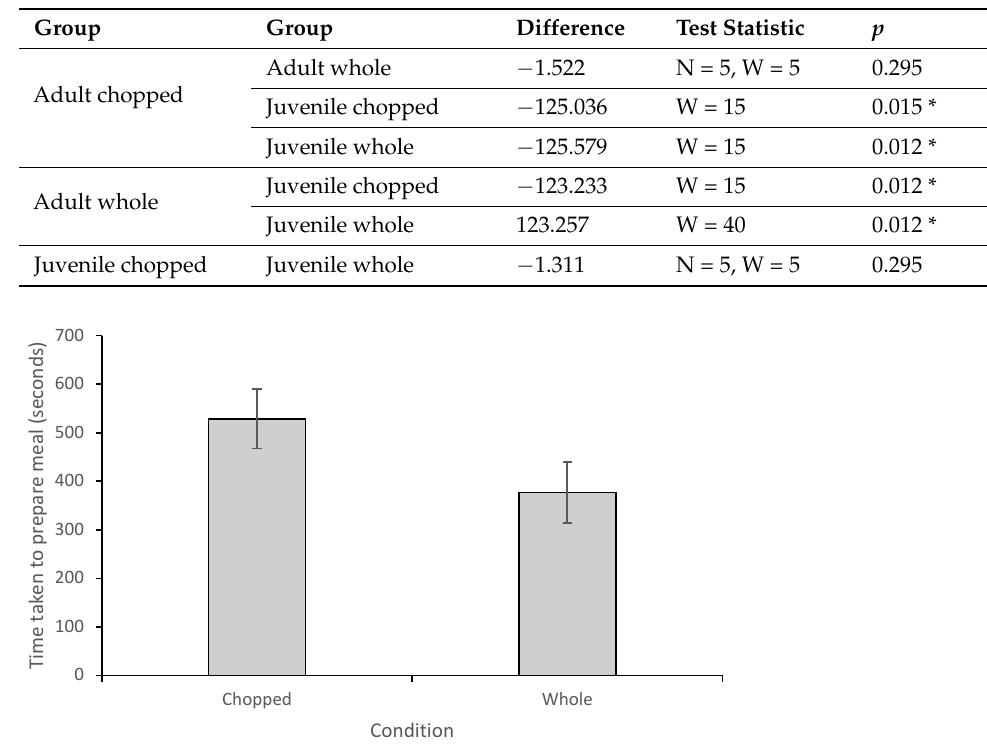
Figure 4. Average amount of food eaten by the adult and juvenile White-cheeked Turacos, +/ − standard error. Table 5. Pairwise comparisons between the amount of food eaten by adult and juvenile birds under chopped and whole-food conditions. Significant values are indicated by an asterisk.